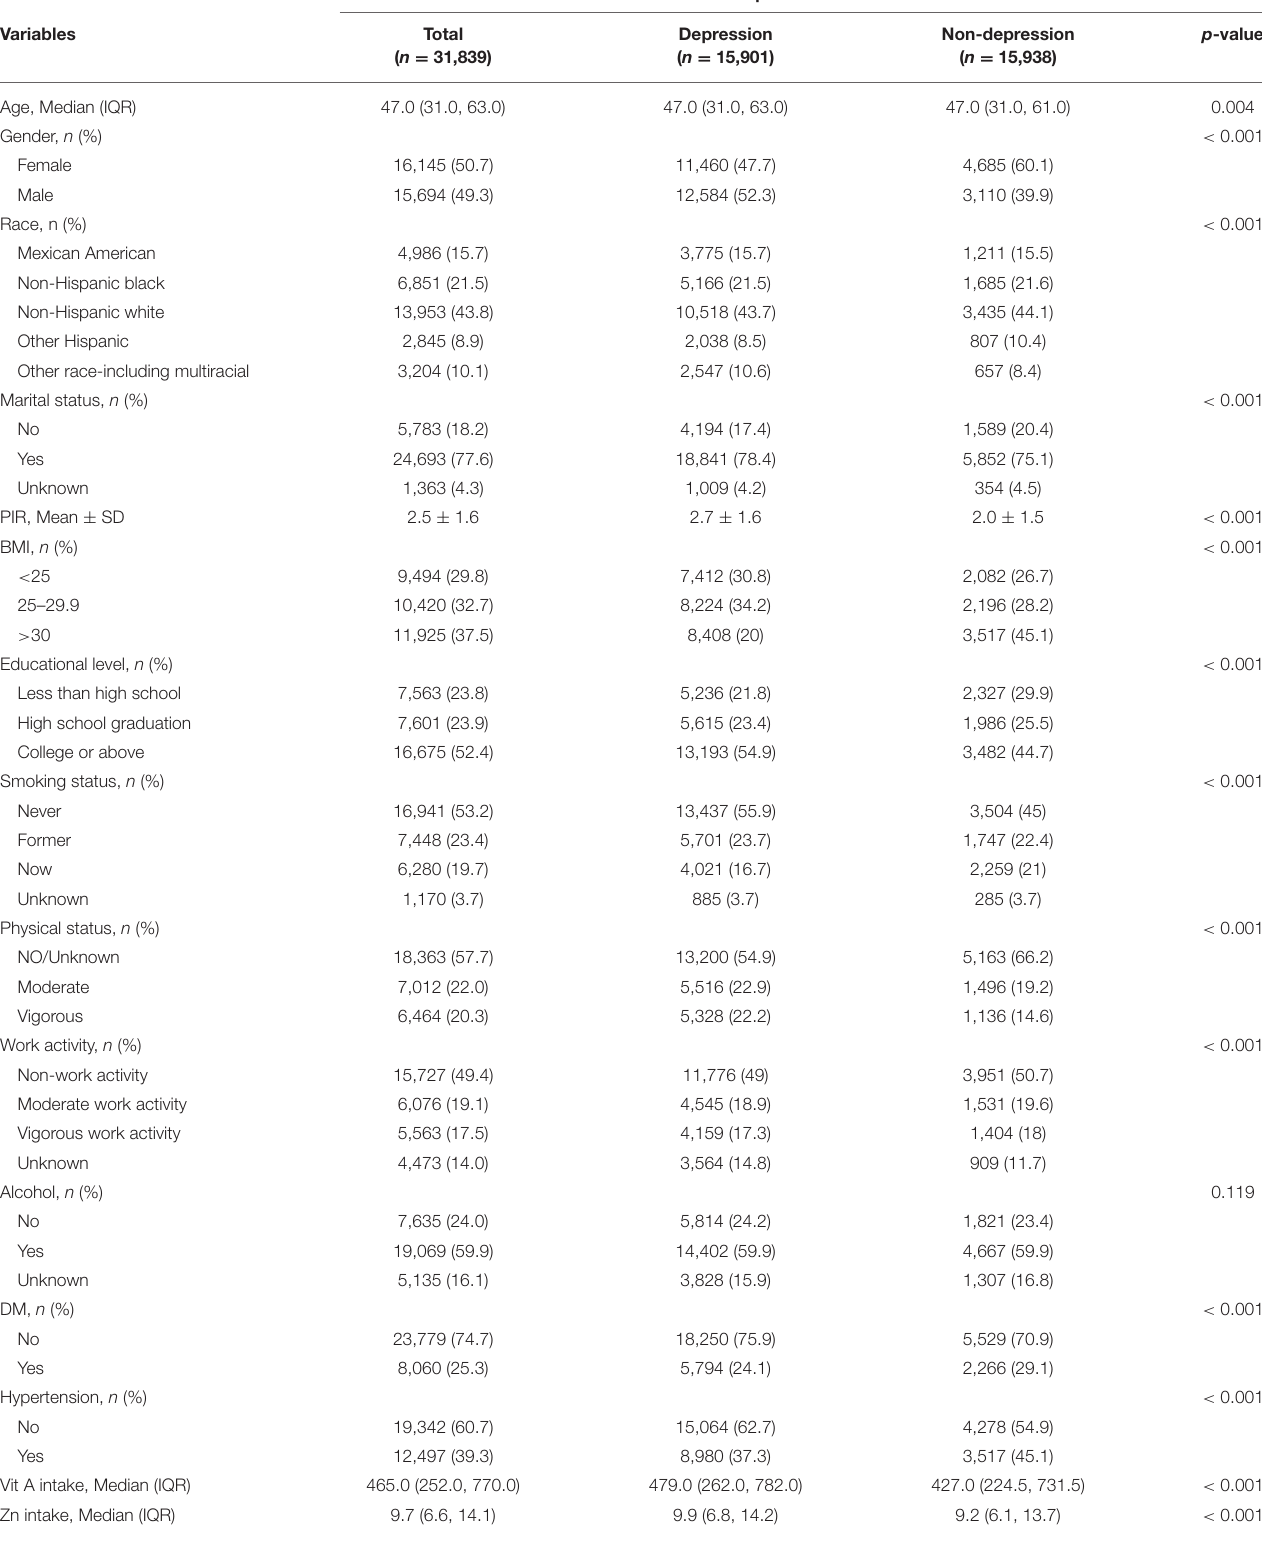
TABLE 1 | Baseline characteristics of study